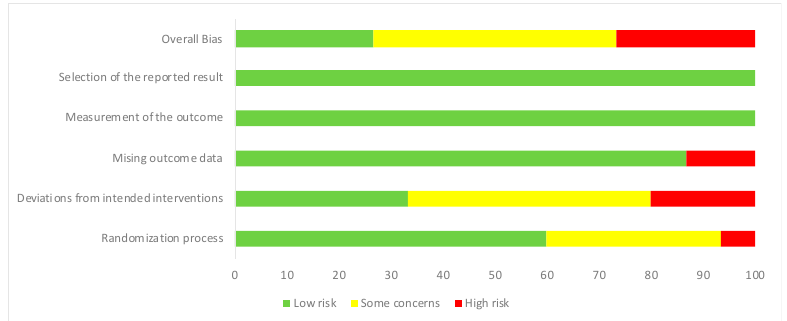
Figure 2. Risk of bias graph: risk assessment across all included studies.